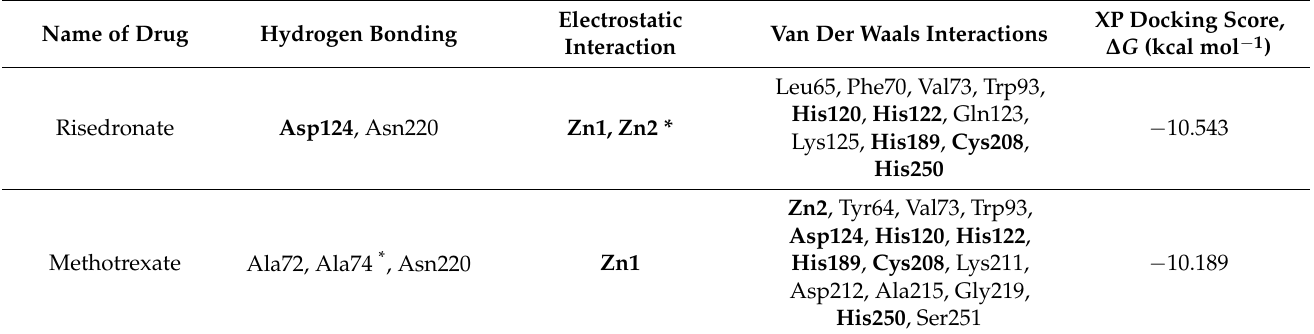
Table 3. Docking parameters for the interaction between identified inhibitors and